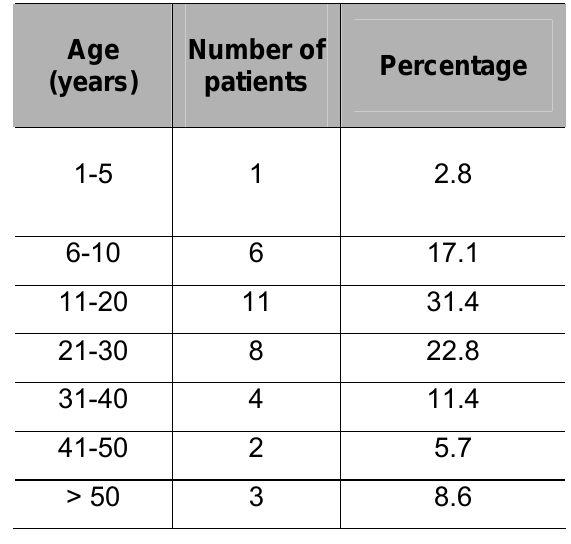
Table 1. Age distribution of neurotoxic snakebites (n =